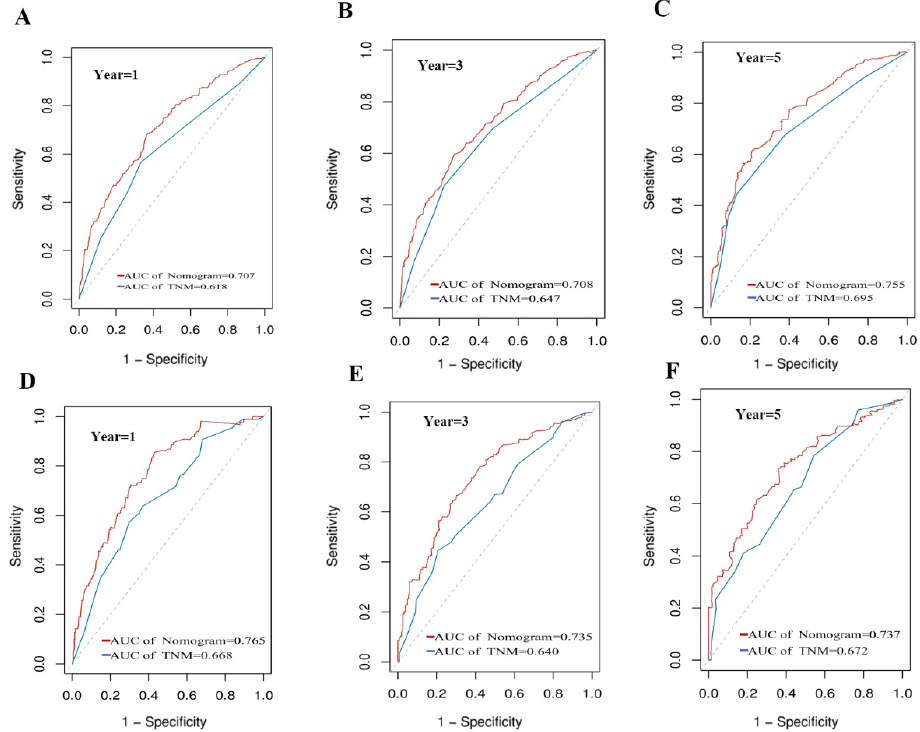
Figure 4. Comparison of the ROC curves of the nomogram and the TNM stage for 1-, 3-, and 5-year CSS prediction in the training set ( A – C ) and validation set ( D – F ).